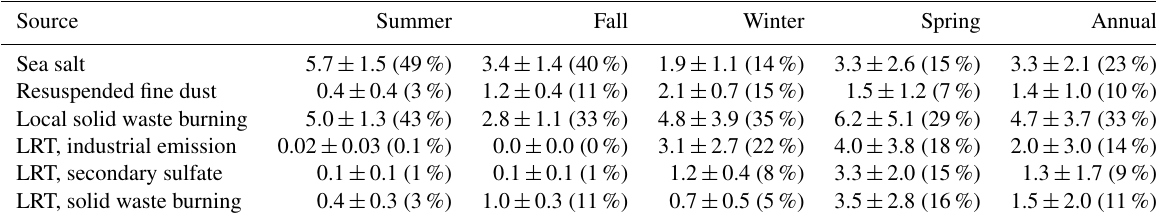
Table 3. Summary of seasonal and annual source profile contribution (unit is µgm − 3